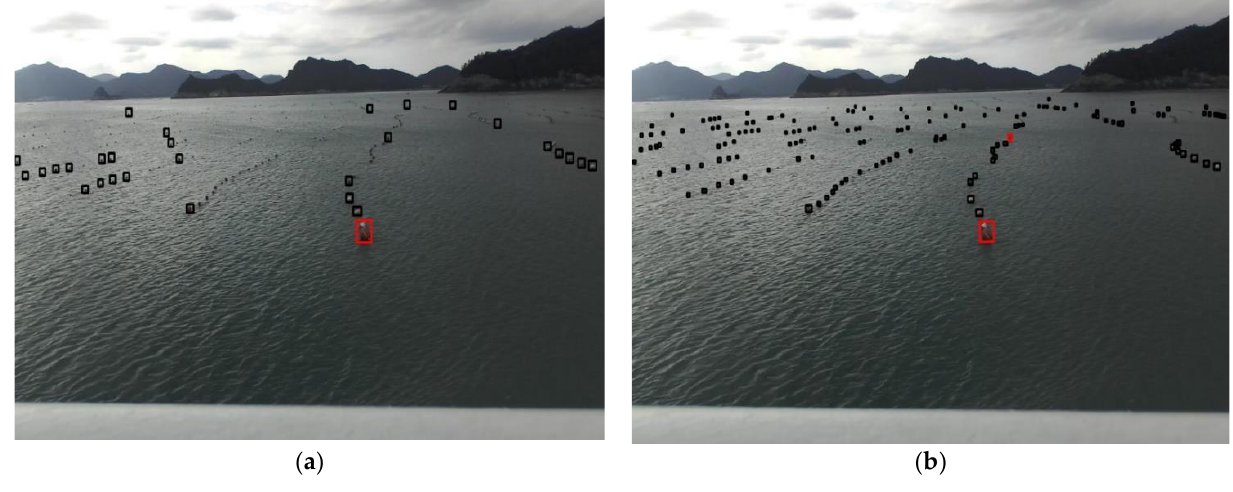
Figure 18. Detecting results (Experiment B): ( a ) input size 640 and ( b ) input size 2208.